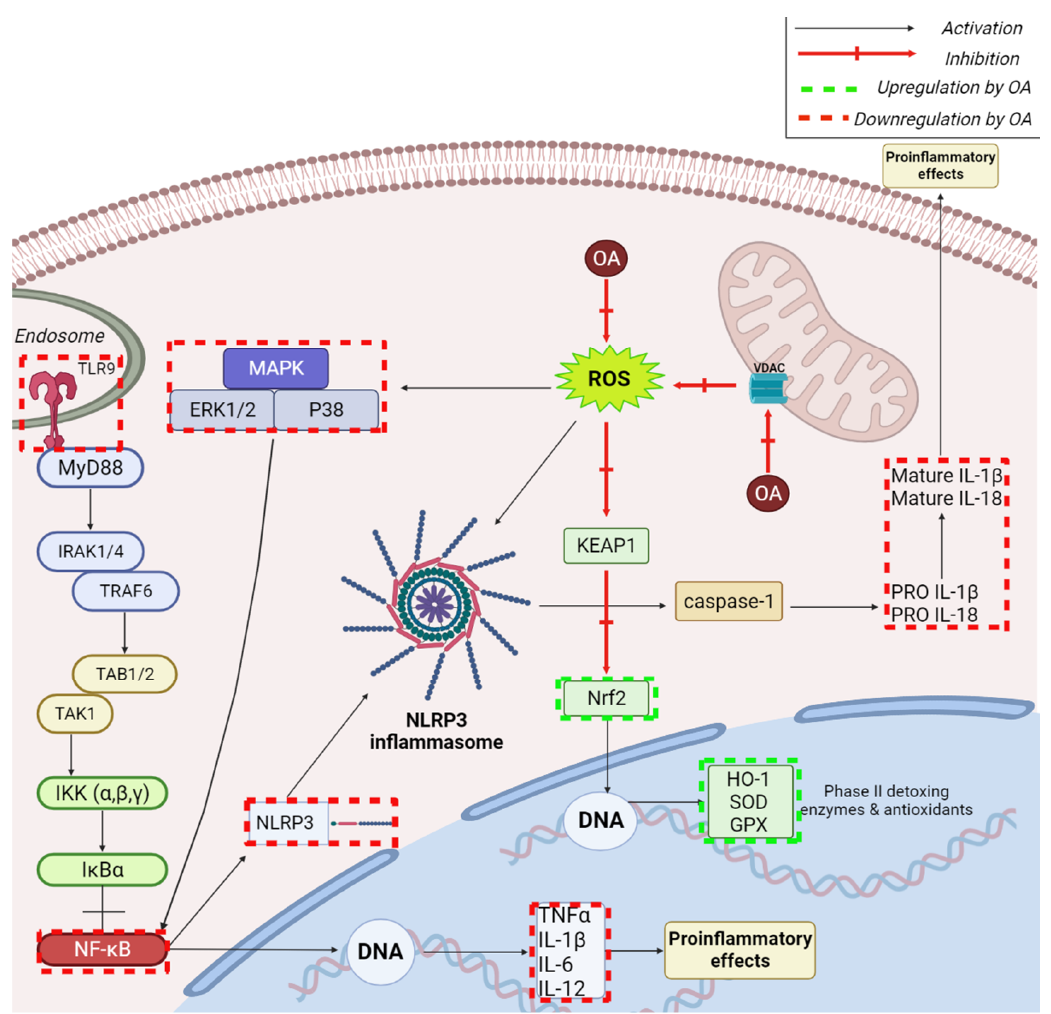
Figure 11. Schematic representation of the reported antidiabetic mechanisms of OA; key signaling pathways targeted by OA in diabetes: NF-kB signaling inhibition -> reduces IL-6 and TNF-α inflam- matory cytokines -> antioxidant effect; NLRP3 inflammasome inhibition -> reduces expression of pro-inflammatory cytokines -> anti-inflammatory effect; MAPK signaling inhibition -> antioxidant effect; HO-1/Nrf2 pathway up-regulation- antioxidant effect. Created with BioRender.com (accessed on 8 May 2022).